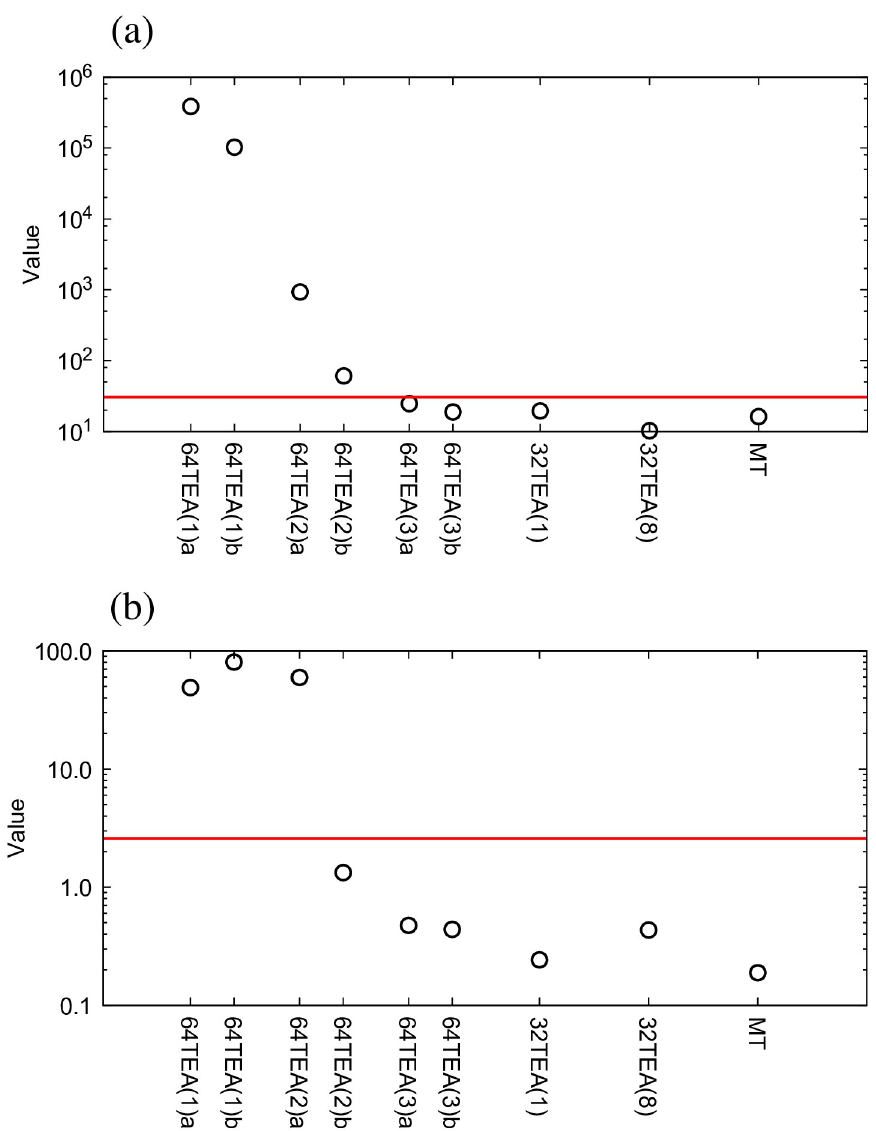
Fig 2. The results of (a) χ 2 -test, (b) t-test. The red line indicates a significance level of 1%. comparison of the velocity distribution with theoretically predicted values and error rates. The error rate was calculated as follows, where P ( v ) is the probability distribution function of v ( i = x , y , z ), and P ( v ) is its theo- theoretical i i retically calculated counterpart. From this figure, it seems that the simulated distribution is a close match to the theoretical one. The median value ( v = 0) has an error of about 2%, which is the same error rate as found with the Mersenne Twister. (Fig 4(c)) On the other hand, for the TEA versions which did not pass the above tests, such as 64TEA(2), we may see from